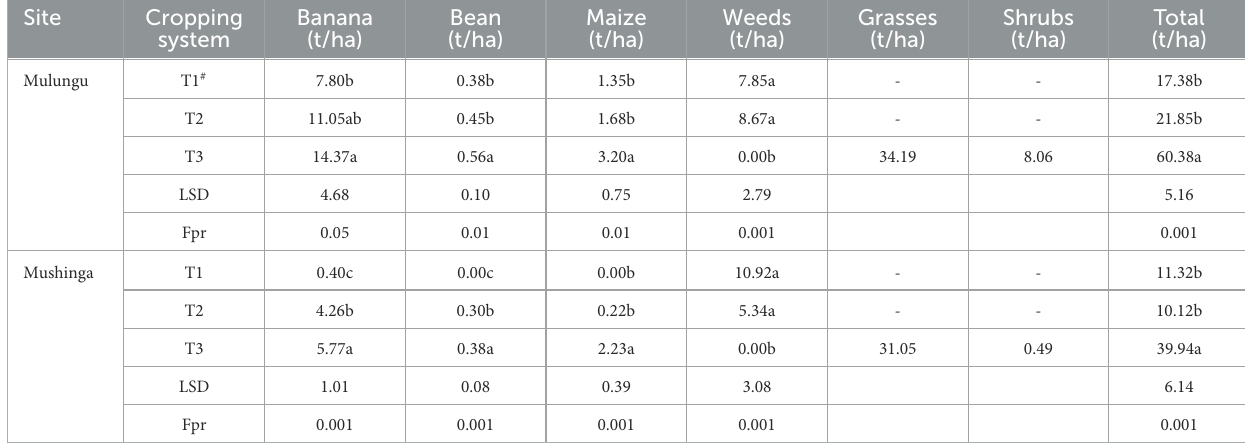
TABLE 3 Mean aboveground biomass yield (dry weight basis) for different crops, weeds, grasses and shrubs and total biomass yield for three land management packages at two experimental sites in eastern Democratic Republic of Congo assessed after 4 years of experimentation. Site Cropping